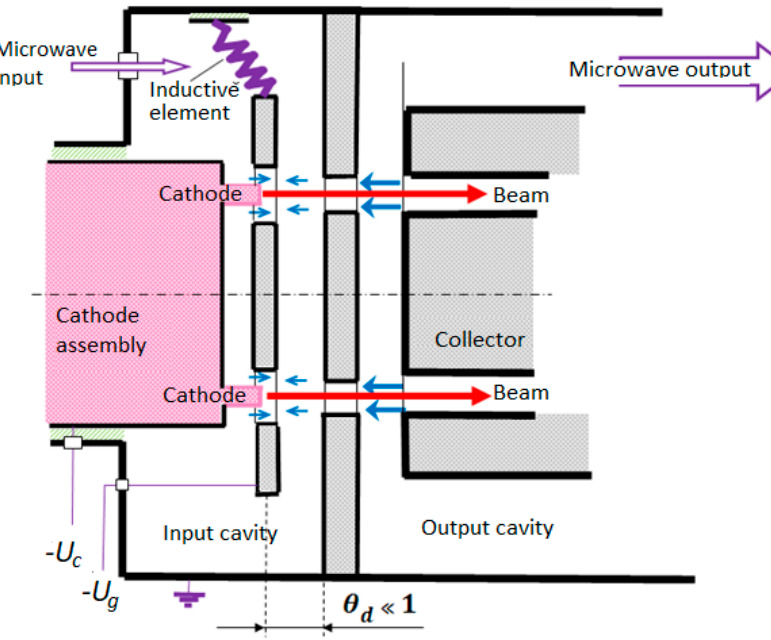
Figure 12. Scheme of a resotrode with 0-regeneration .